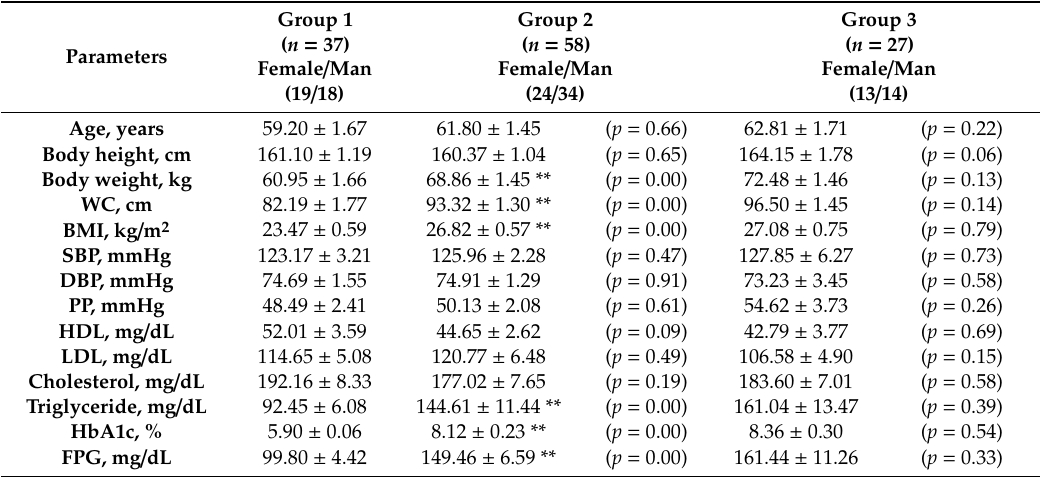
Table 1. Anthropometric, hemodynamic, and serum biochemical parameters of the testing subjects.